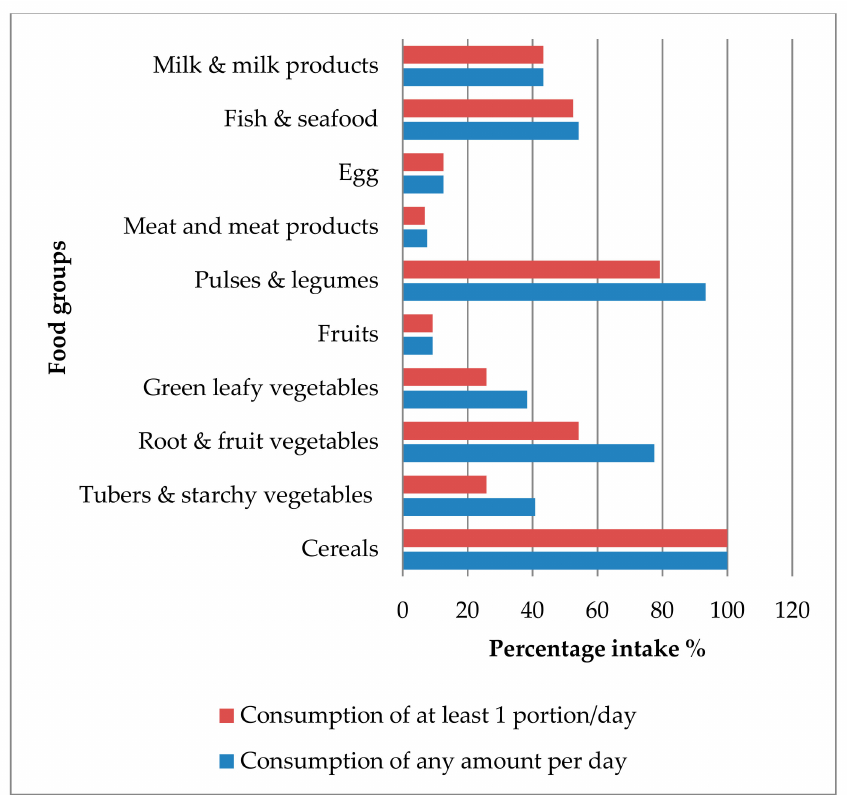
Figure 1. Consumption of di ff erent food groups during the previous 24-h period.